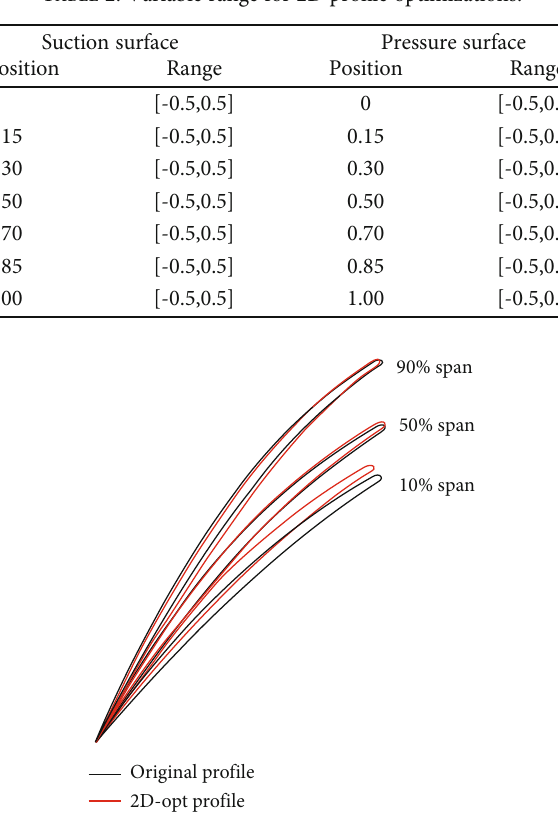
Figure 6: Comparison between the initial and optimized pro fi les. Table 3: Comparison between performances of the original and optimized pro fi